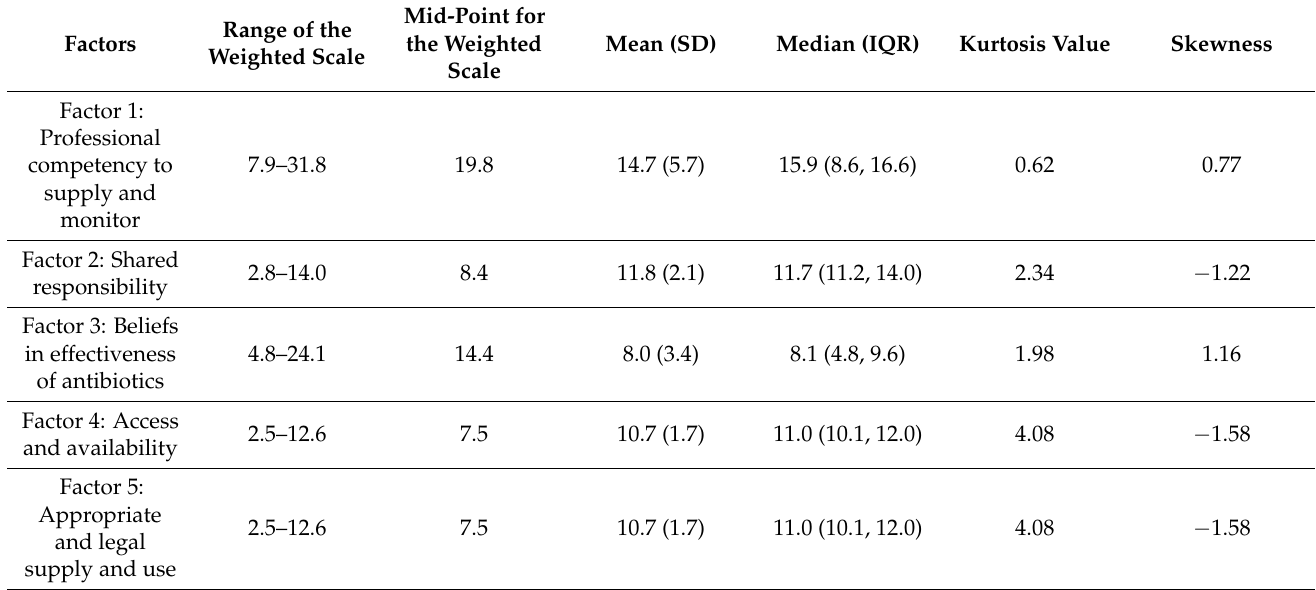
Table 3. Weighted factor-based scale